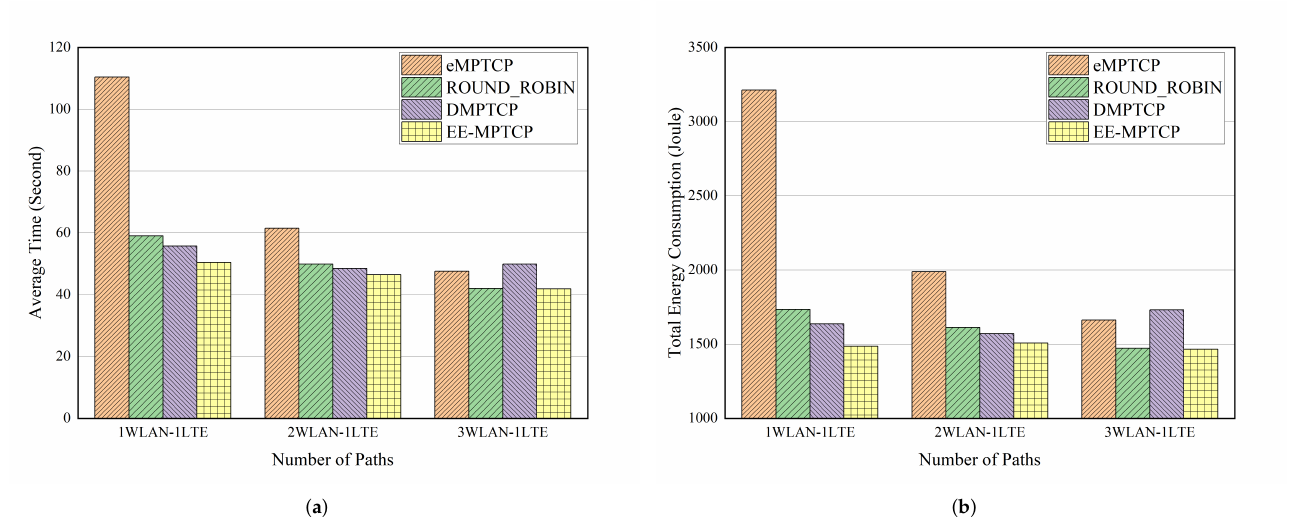
Figure 8. The evaluation results of the four algorithms, namely eMPTCP [14], the default ROUND- ROBIN, DMPTCP [27] and the proposed EE-MPTCP with varying number of subflows that consists of 1 LTE path and 1–3 WLAN paths. ( a ) The average completion time of all flows. ( b ) The total energy cost during the whole transmission.